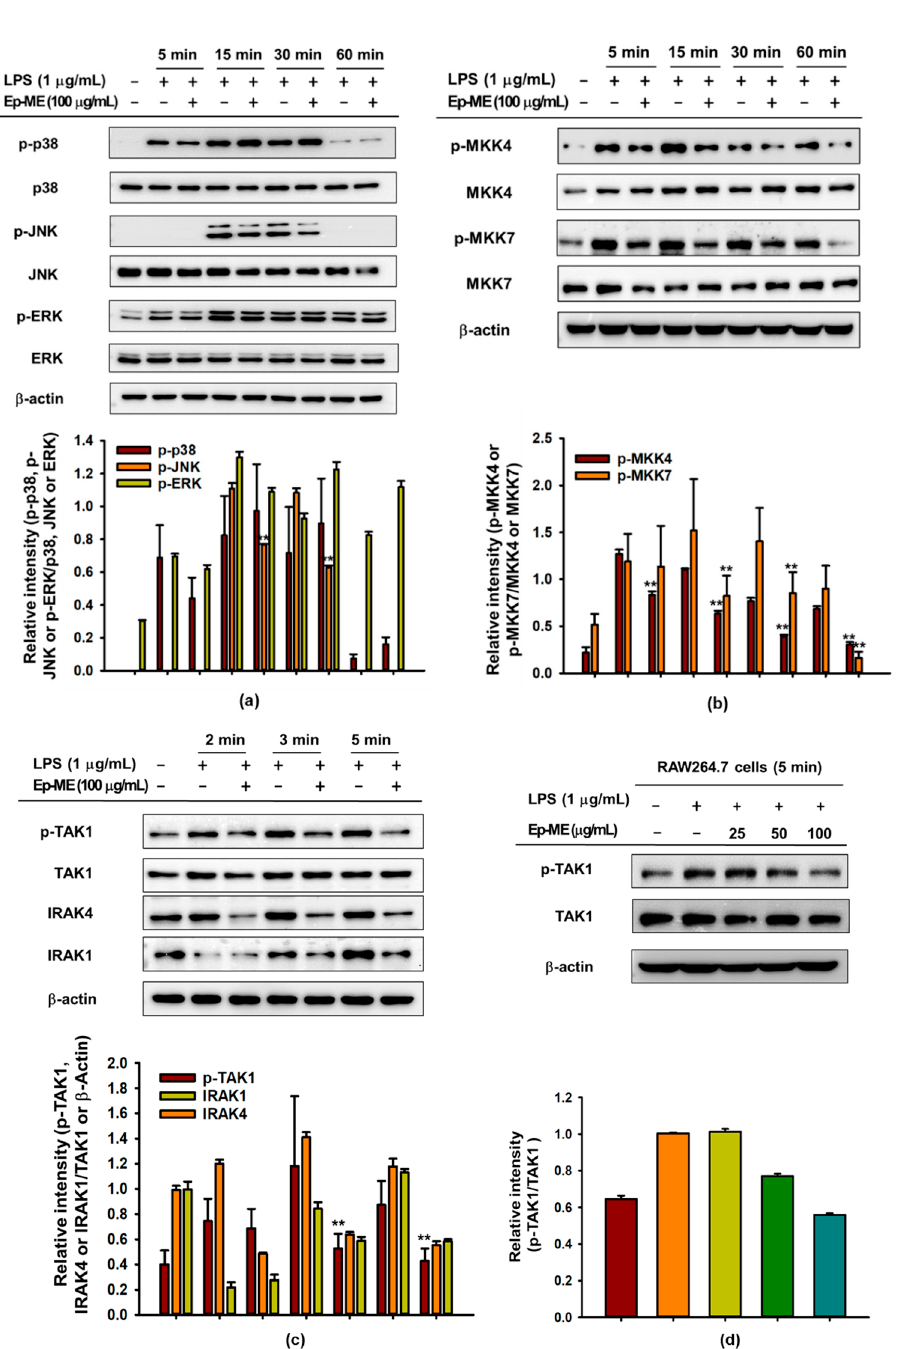
Figure 3. The e ff ects of Ep-ME on the activation of the AP-1 signaling pathway. ( a – d ) The levels of the phosphorylated and total forms of JNK, ERK, p38, MKK7, TAK1, MKK4, IRAK1, IRAK4, and β -actin were identified by immunoblotting analyses. The relative intensity is quantified through ImageJ. The data presented in ( a – d ) are a representative of three independent experiments. ** p < 0.01 vs. control